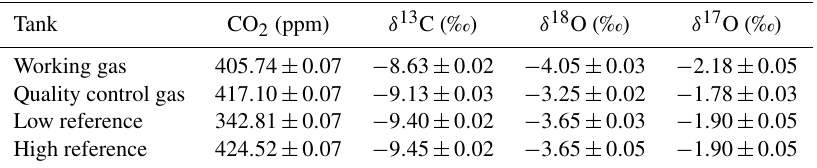
Table 5. Calibrated whole-air working standards used in daily operation of the SICAS measurements. CO 2 measurements were conducted in our lab on a PICARRO G2401 gas mole fraction analyzer, and the δ 13 C and δ 18 O values were measured at the MPI-BGC with a MAT-252 dual-inlet IRMS. The δ 17 O values of the working gas and the quality control tank were measured at the IMAU, while the δ 17 O values of the low and high references were indirectly determined using our own measurements on the SICAS. Errors are all combined errors, including measurement precision, measurement accuracy and scale